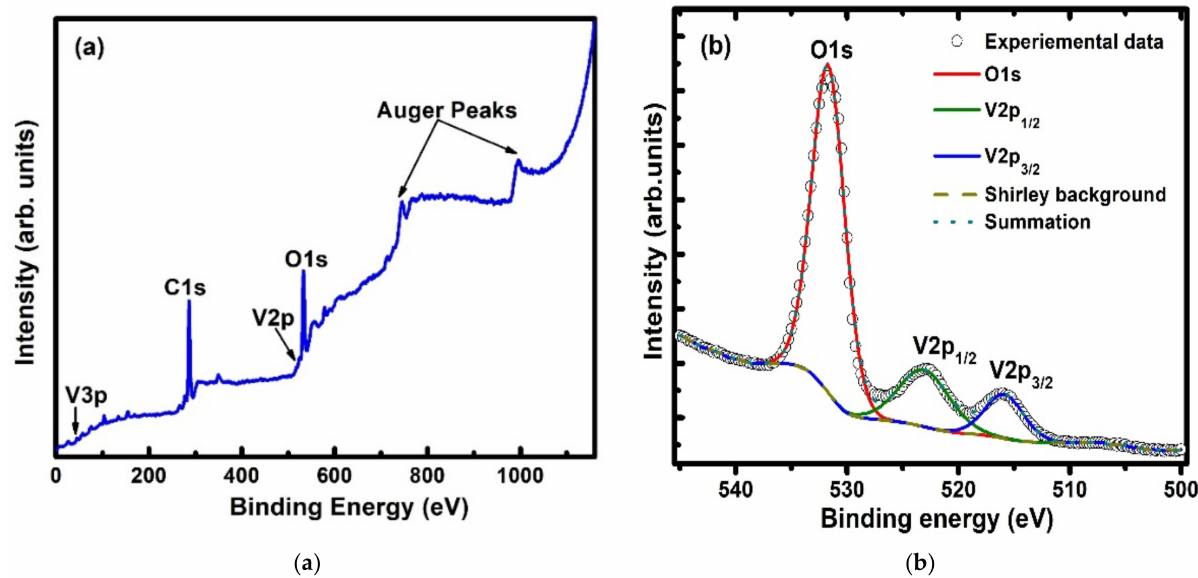
Figure 3. ( a ) Survey XPS spectrum and ( b ) analysis of high resolution XPS peaks in V 2 O 3 thin films corresponding to vanadium and oxygen elements.